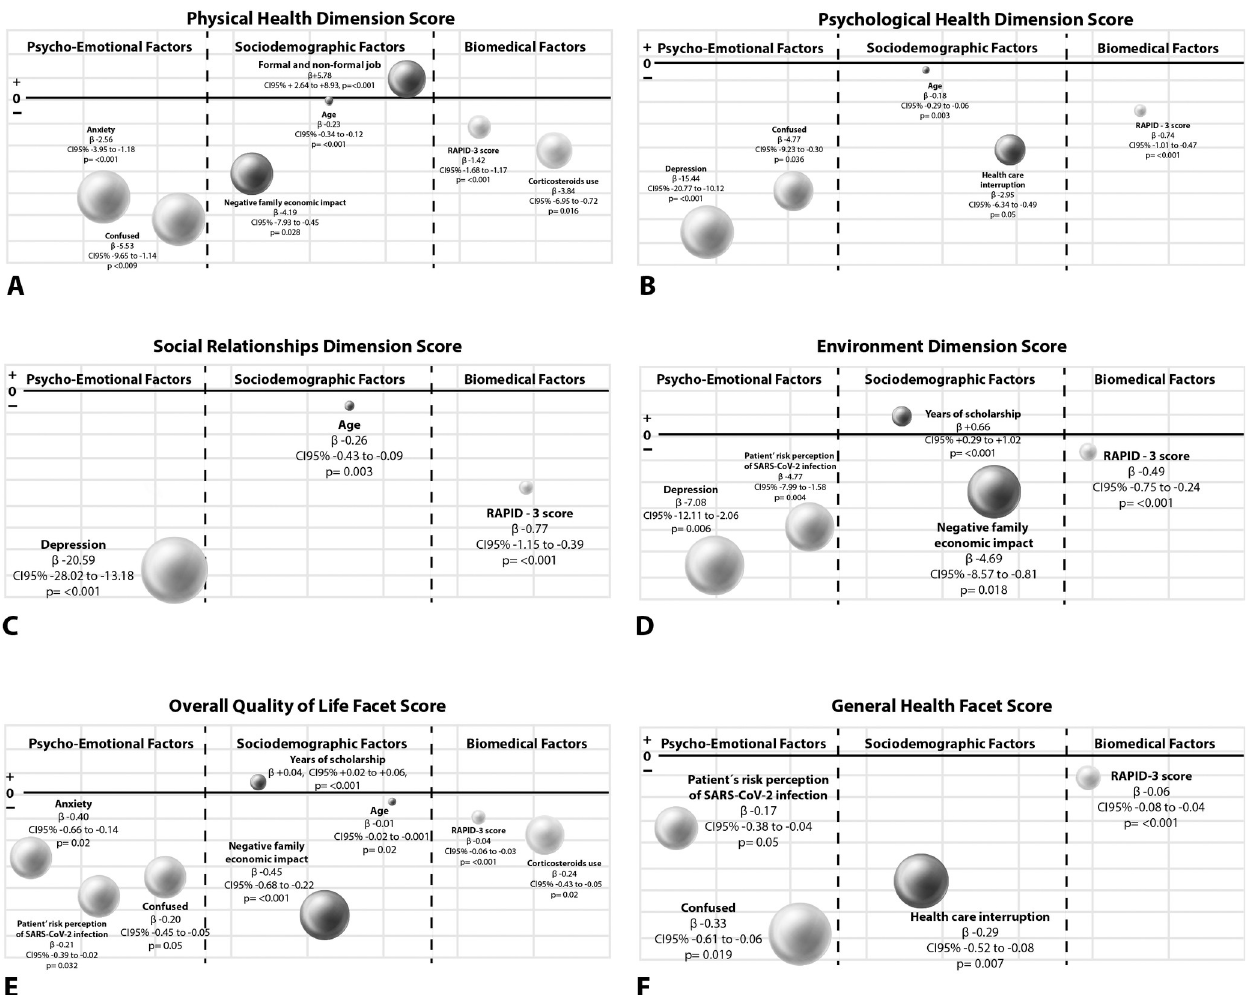
Fig 3. Factors associated with baseline QoL dimensions/facets scores: 3A Physical health dimension, 3B Psychological health dimension, 3C Social relationships dimension, 3D Environment dimension, 3E Overall QoL facet and 3F General health facet. Factors associated with QoL dimensions and facets scores are distributed into three columns. The column located at the left side of the figure includes psycho-emotional factors, while the column located at the right side includes biomedical factors. Sociodemographic factors are located in the column left. The size of each sphere is in accordance with B coefficient magnitude (multivariate linear regression analysis). Meanwhile, the space between spheres does not meant to represent any relevant data.